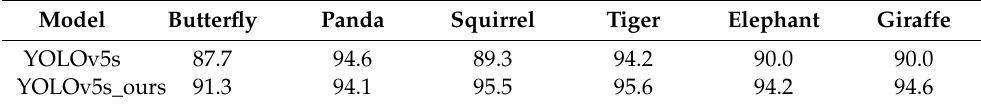
Table 2. Experimental results of various types of wildlife testing before and after improvement. Model